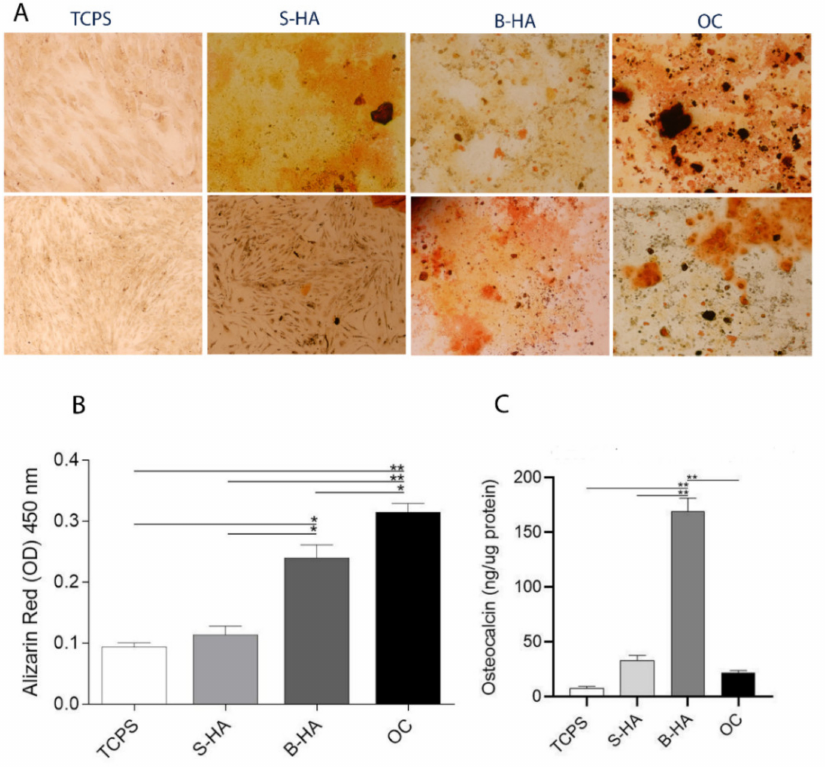
Figure 3. Osteogenic markers in human adipose stem cells (hASCs) cultured on biomorphic HA (B-HA), sintered HA (S-HA) biomaterials. ( A ) Alizarin Red staining is shown in this panel, in experimental conditions tested (10 × magnification upper figures, 4x magnification lower